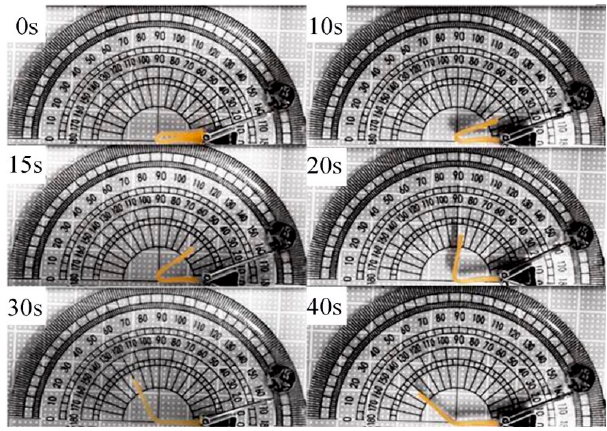
Table 3. Average shape recovery rate of all the samples.